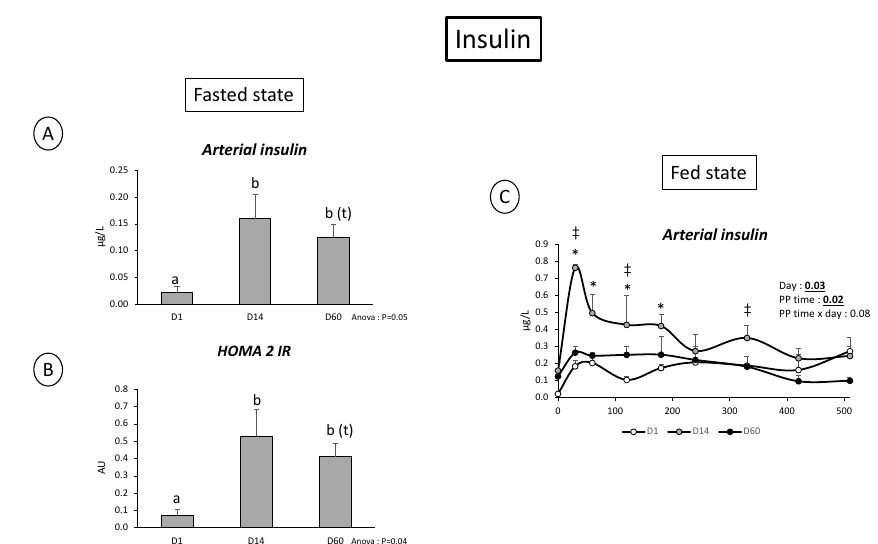
Figure 6. ( A ) Arterial insulin concentration ( µ g/L) in the fasted before (D1) and after 14 days (D14) and 60 days (D60) of adaptation to HFHS diet. ( B ) HOMA 2 IR (UA) in the fasted state before (D1) and after 14 days (D14) and 60 days (D60) of adaptation to HFHS diet. ( C ) Insulin concentration ( µ g/L) after meal intake (Post prandial state, PP: 0 to 510 min) in artery before (D1) and after 14 days (D14) and 60 days (D60) of adaptation to HFHS diet. Fasted state: One way RM ANOVA: with different letters: significantly different; (t): tendency. Fed state: Two way RM ANOVA, * D14 significantly different from D1, † D60 significantly different from D1, ‡ D60 significantly different from D14; Values are means ± SEM. For calculations and statistical treatment of the data and for details, see Materials and